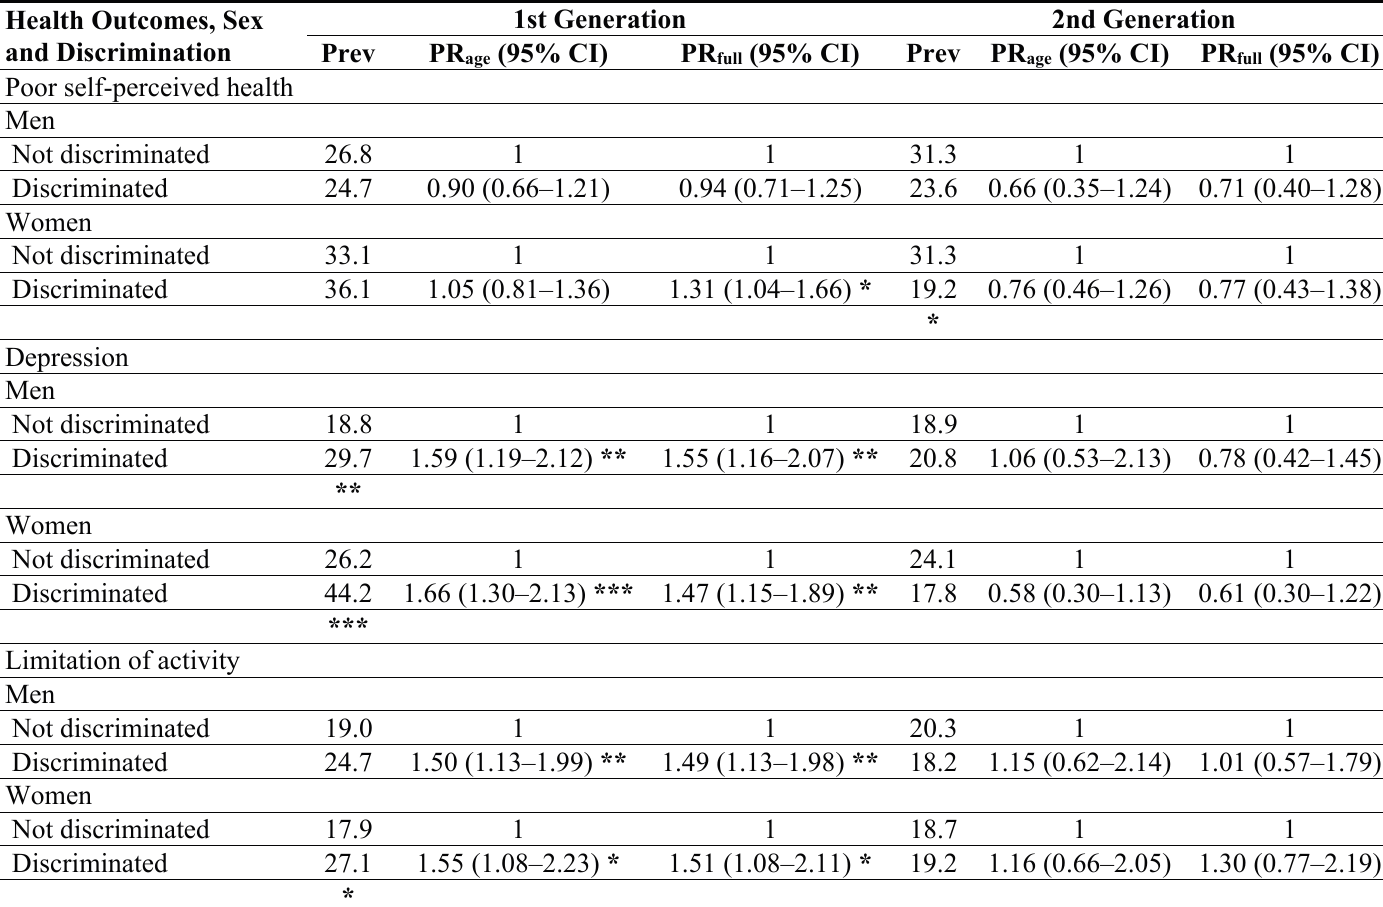
Table 2. Prevalence of health outcomes. Association of perceived group discrimination with poor health outcomes (prevalence ratios): age adjusted model and all adjusted; men and women by immigration